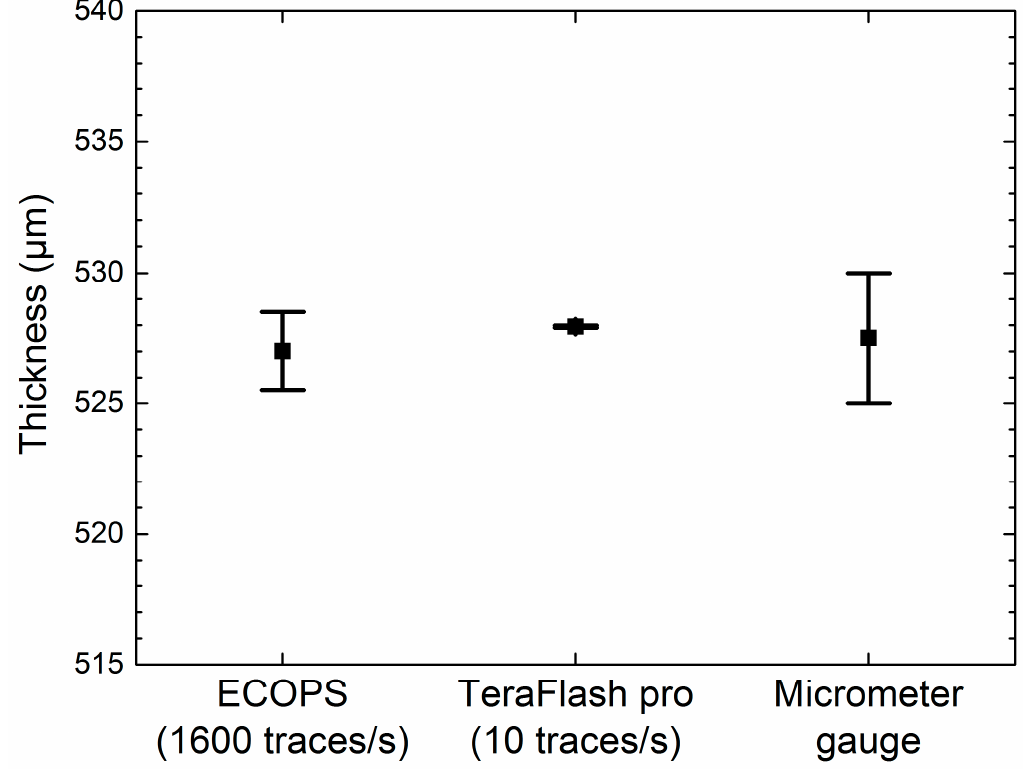
Figure 7. Thickness measurement results of a single point on the silicon wafer, obtained with ECOPS, the TeraFlash pro and the micrometer gauge. Measurements with ECOPS and the TeraFlash pro were repeated 10,000 times each, and the micrometer gauge measurement was repeated 50 times. The error bars represent the standard deviation of the results.